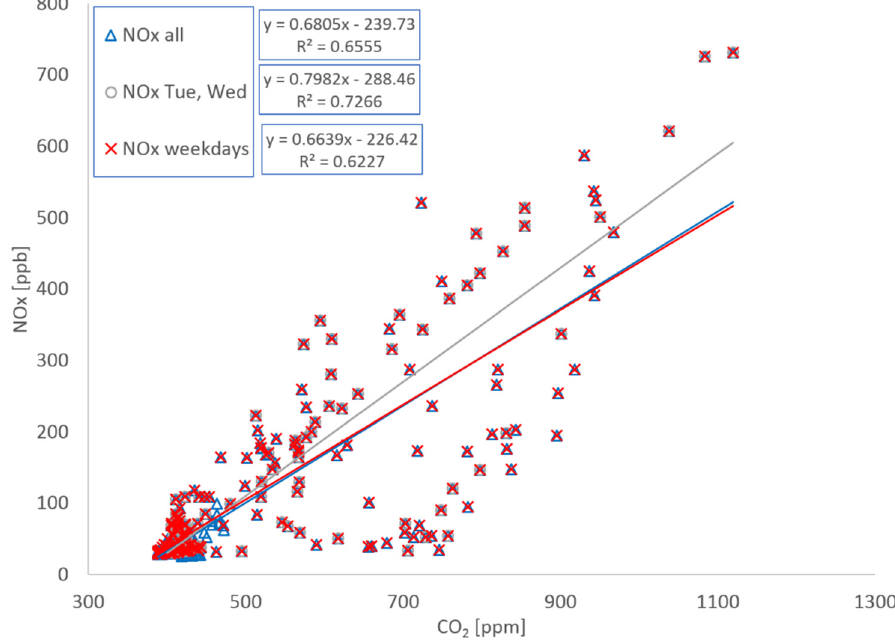
Figure 7. NOx plotted against CO 2 for three data sets: all data, all weekday data, all complete 24 h data sets—in this case Tue and 2nd Wed.